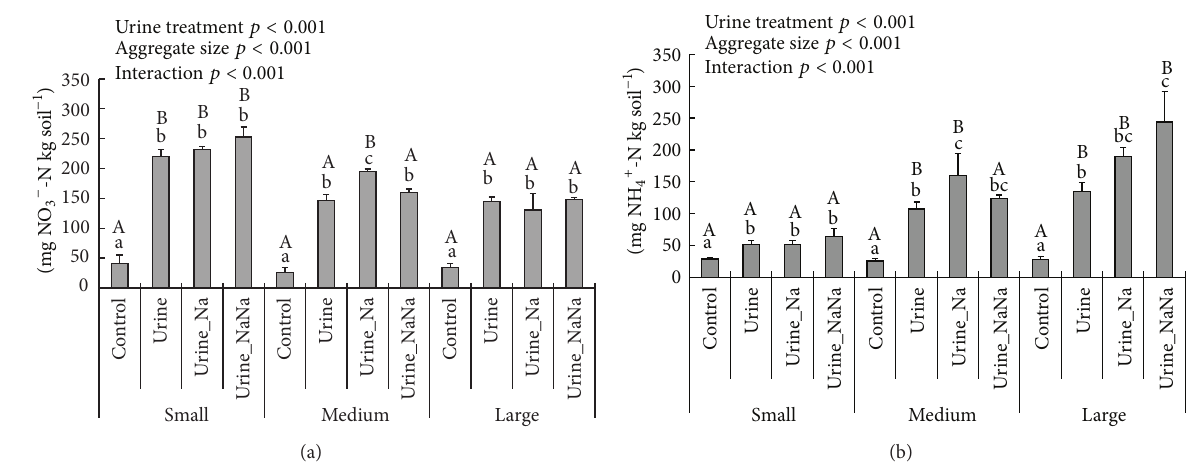
Figure 3: The amount of inorganic-N remaining in soils after the three simulated heavy rain events. The amounts of (a) NO 3− -N and (b) NH 4+ -N were shown in separate figures. The error bars indicate standard deviations ( 𝑛 = 3 ). The small letters on each bar indicate significant difference within each aggregate size. The capital letters indicate significant difference within each treatment to show the effect of aggregate size on each urine treatment.